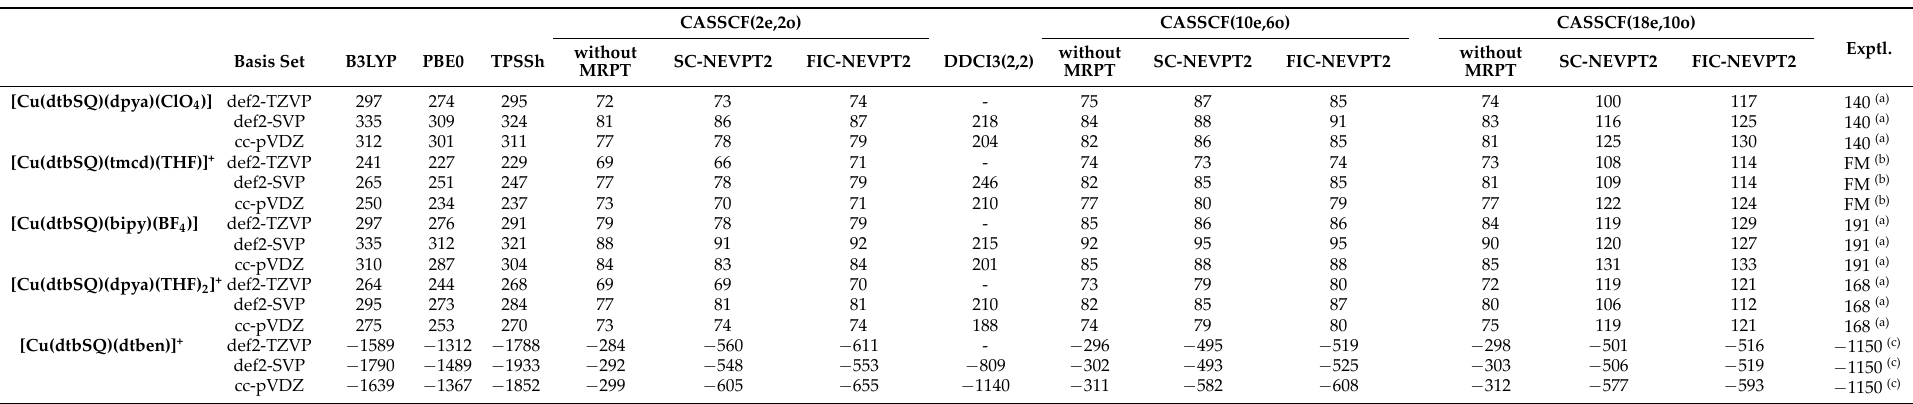
Table 2. Exchange coupling constants J (in cm characterized